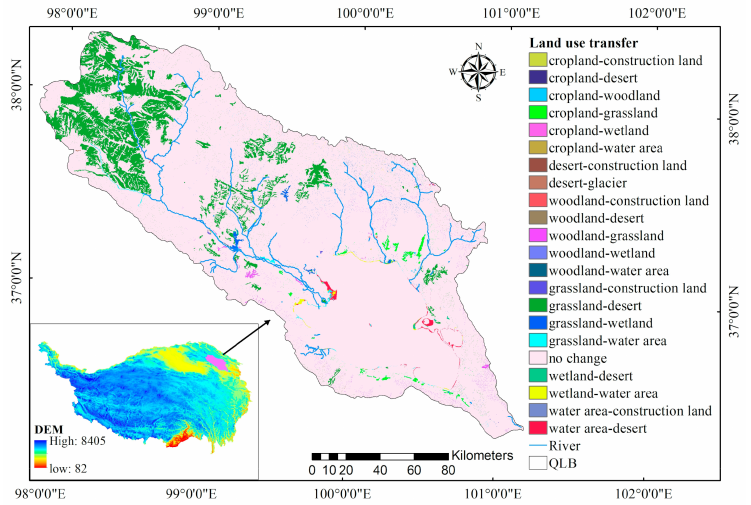
Figure 7. Spatial distribution of land use transfer flows in the QLB from 1990 to